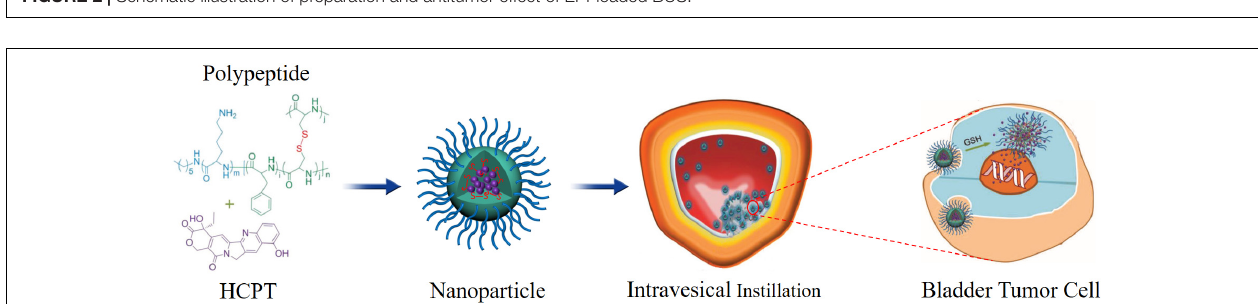
FIGURE 2 | Schematic illustration of preparation and antitumor effect of EPI-loaded BUS.